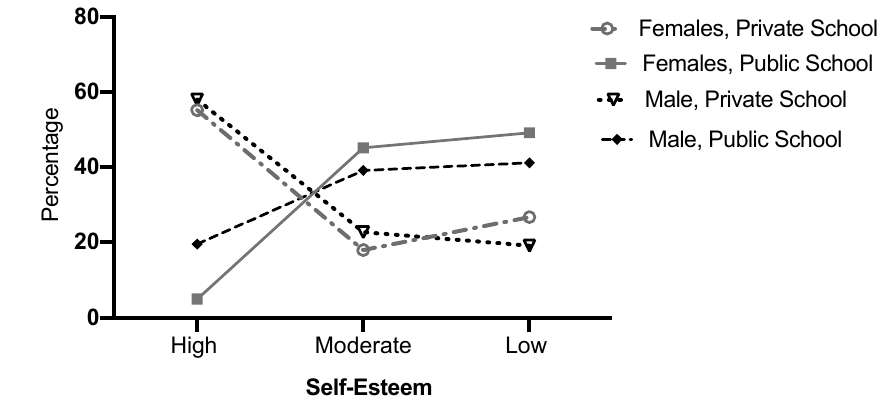
Figure 2. Level of self-esteem by sex and school type, expressed in percentages.